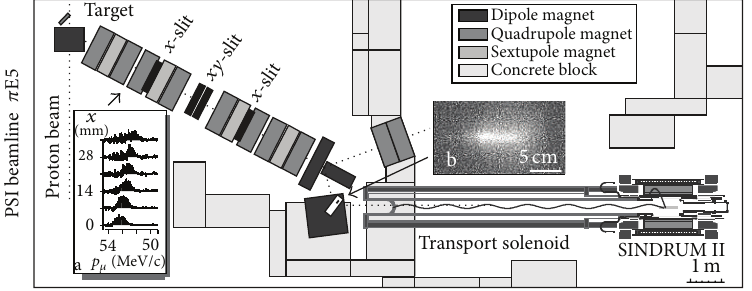
Figure 23: Schematic planar view of the SINDRUM II